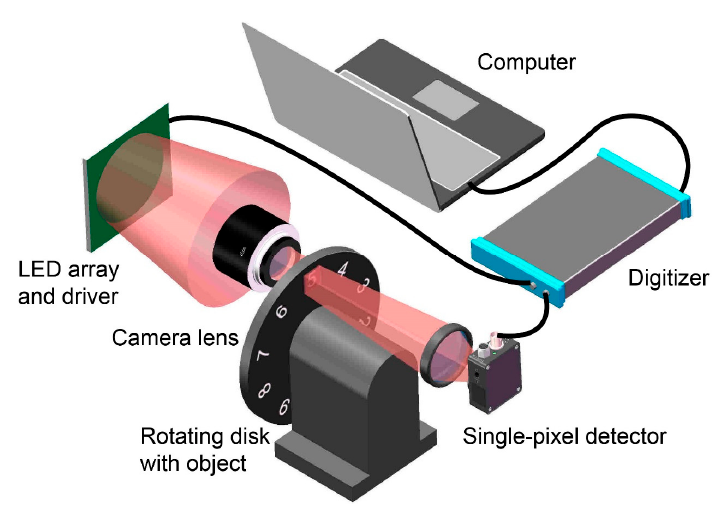
Figure 4. The experimental LED-based computational ghost imaging